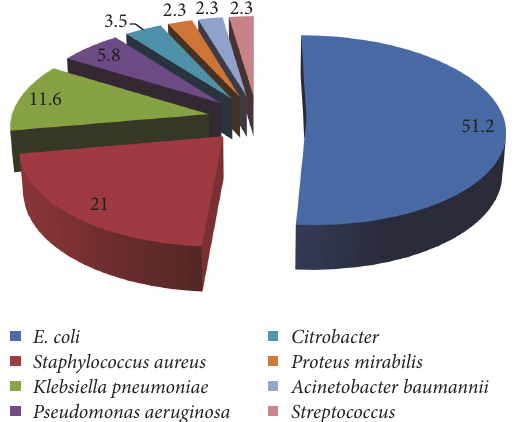
Figure 1: Distribution of bacterial pathogens (%) isolated from pus samples at a tertiary care hospital in Punjab,